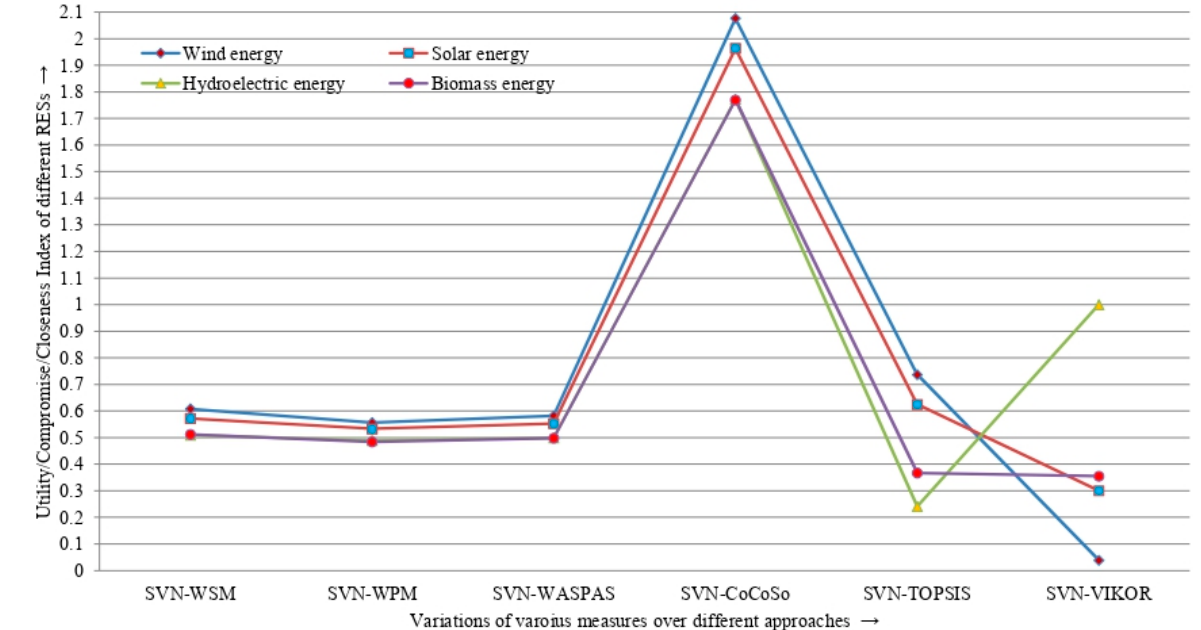
Figure 3. Comparison of proposed with extant methods for RESs selection.